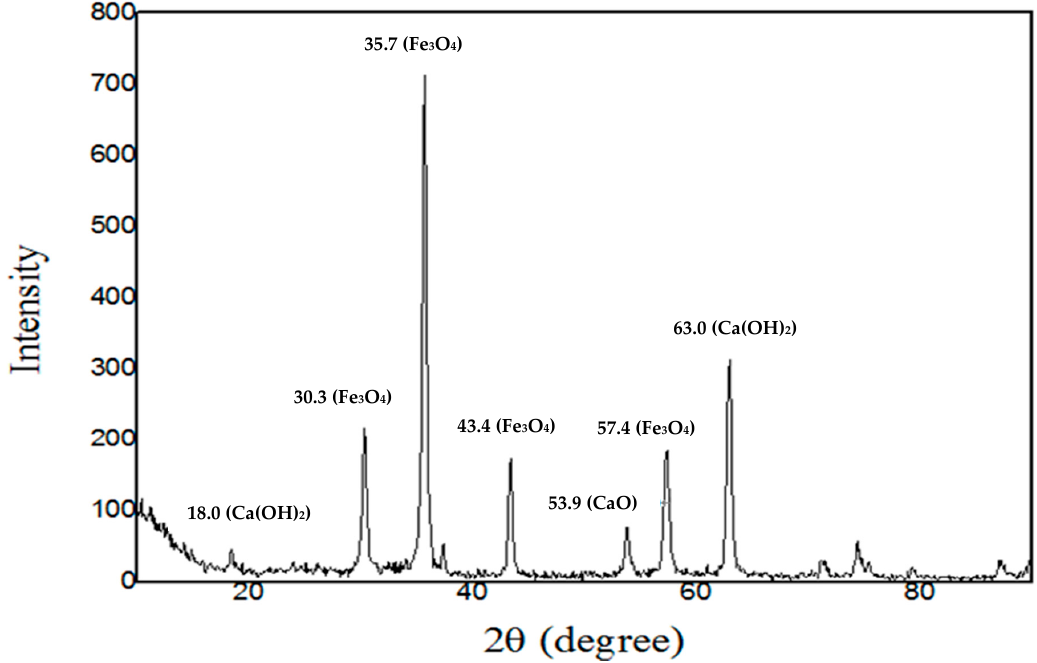
Figure 1. The X-ray diffractometer (XRD) pattern of the synthesized catalyst, nano-Ca(OH) 2 /Fe 3 O 4 .